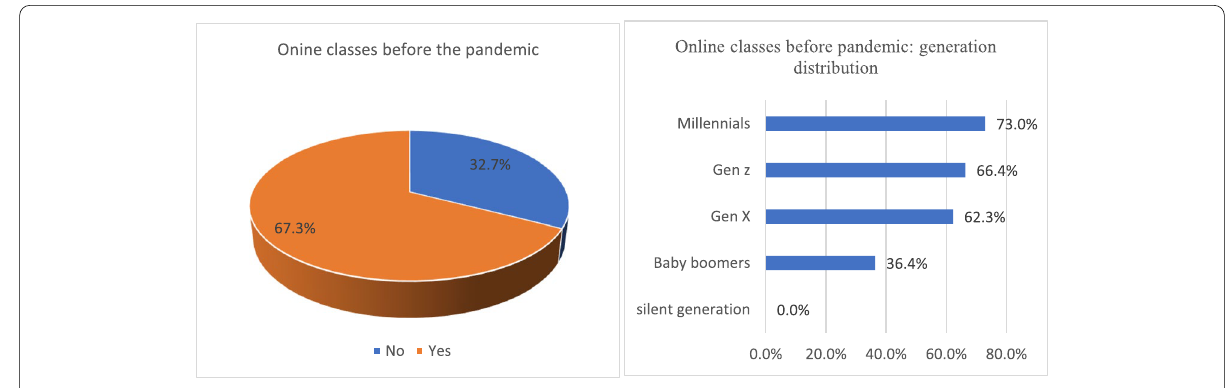
Fig. 1 Online class participation before Covid-19